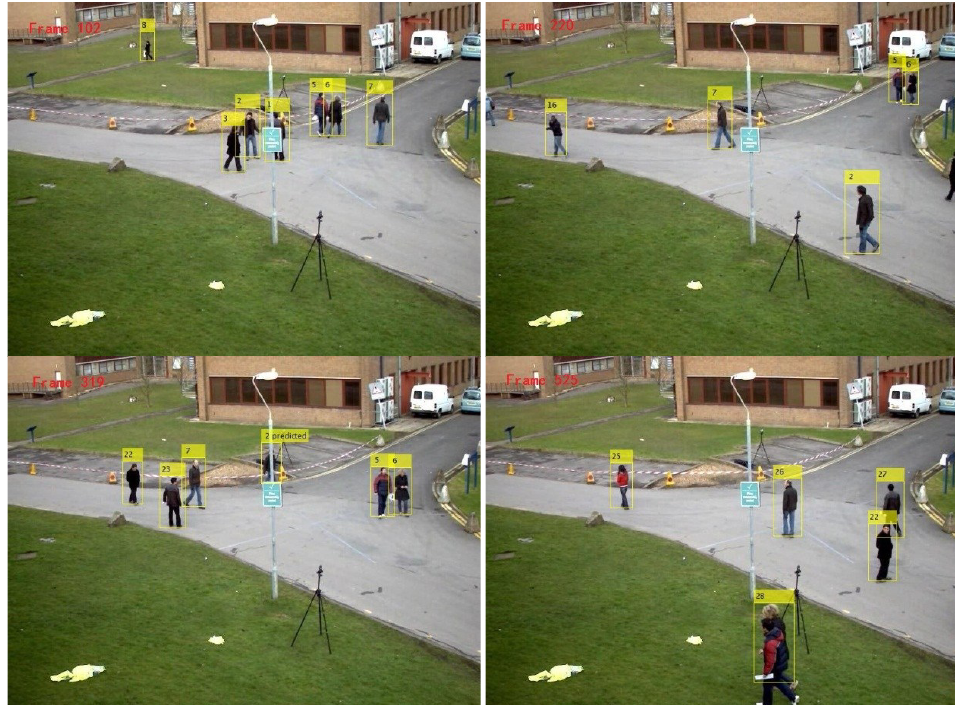
Figure.4. Results of the proposed algorithm on PETS.S2L1 dataset